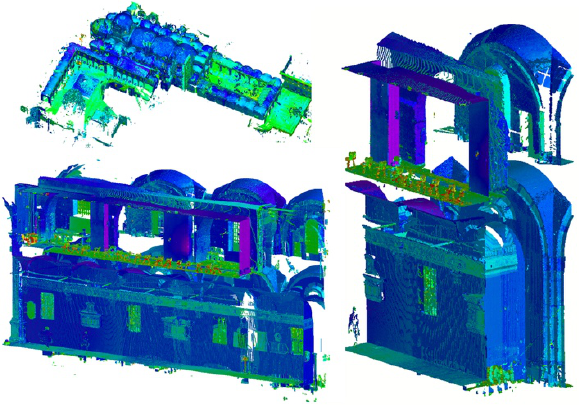
Figure 4. Point clouds data of the Basilica of Sant’Ambrogio. Scans were registered with an average precision of ±3.0 mm by using chessboard targets measured with the total station and additional scan-to-scan correspondence (spherical targets). A photogrammetric survey was carried out for each arch and pillar, side and front walls and arch intrados. The main aim of this was to realize orthophotos at the scale 1:10. In order to process the data PhotoScan was used and a set of Ground Control Points (GCPs) and Check Points were derived from the laser scanning survey to constraint the reconstruction and verify the metric accuracy of the final results.